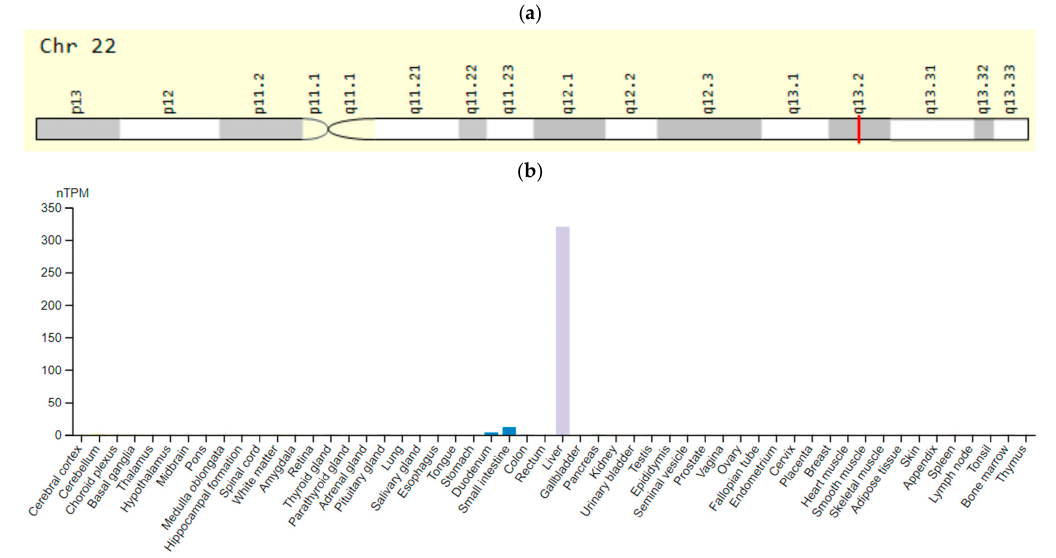
Figure 7. The CYP2D6 gene: ( a )–gene chromosome location; ( b )–protein expression in tissues of the human body [76,77].